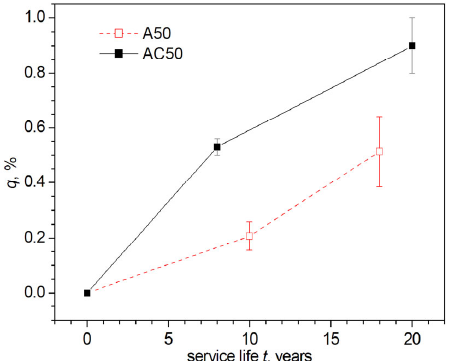
Figure 11. The fraction q of the Al 2 O 3 crystalline phases in wires from A50 and AC50 cables with an exploitation duration of up to 20 years, which is estimated as q = I intAl2O3 / I intAl ∙ 100%, where I intAl2O3 is an exploitation duration of up to 20 years, which is estimated as q = I intAl 2O 3 / I intAl · 100%, where the integral intensity of the 121 δ * ‐ (212 δ ‐ ) Al 2 O 3 reflection and I intAl is the integral intensity of the I intAl 2O 3 is the integral intensity of the 121 δ *-(212 δ -) Al 2 O 3 reflection and I intAl is the integral strongest Al reflection. intensity of the strongest Al reflection.